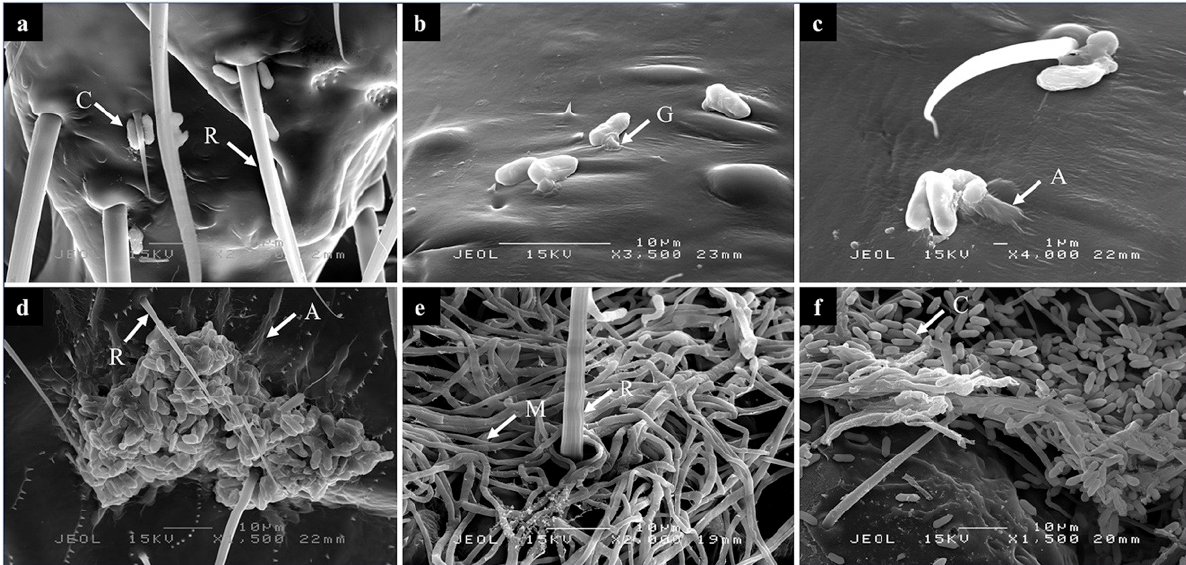
Figure 1. SEM images of Metarhizium anisopliae during development of pathogenesis in Coptotermes curvignathus at different time-points post-inoculation (PI). ( a ) At 6 h PI, pathogenesis starts with the attachment of fungal conidia near hairs of C. curvignathus , ( b ) at 6 h PI, germination of the conidia and penetration through the epicuticle layer, ( c ) at 12 h PI, elongation of appressorium tube along the termites’s exocuticle, and ( d ) at 24 h PI, most of the conidia between the conidial mass attached to the epicuticle layer was germinated and elongated into the integument. ( e ) At 96 h PI, mummification of the termite’s body initiated by elongation of the fungal hypha into mycelium and ( f ) at 144 h PI, emergence of new conidia in abundance on the mycelial mat. R = hair, C = conidia, G = germ tube, A = Appressorium tube, M =